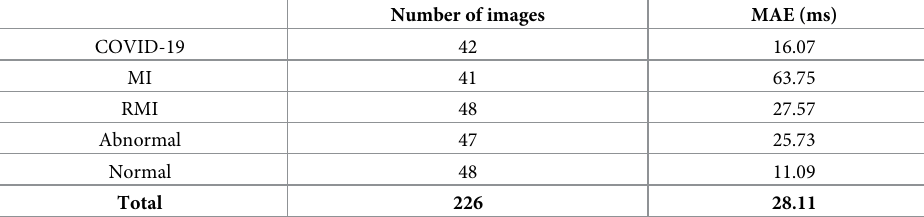
Table 1. Evaluation results of ECG signal quality obtained from image-to-signal conversion algorithm. Evaluation was performed on 226 random samples belonging to 5 classes, with mean absolute error of RR interval of 28.11